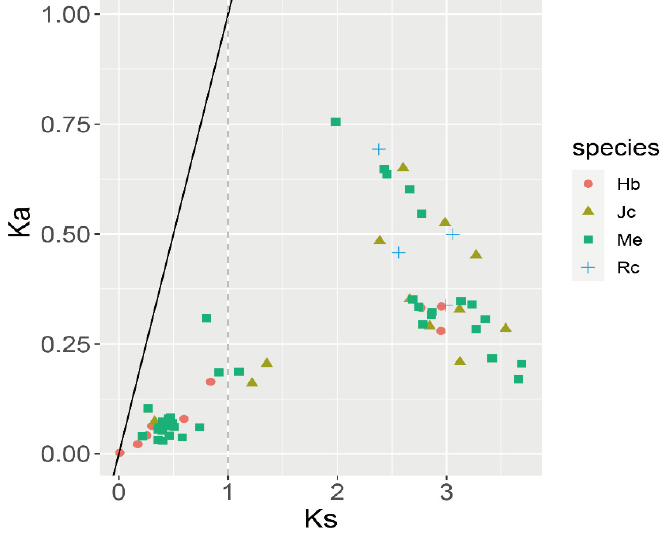
Figure 5. Selective pressure of Euphorbiaceae species LBD duplication genes. Red circles, yellow triangles, green rectangles, and blue crosses represent LBD duplication gene pairs of rubber tree, J. curcas , cassava, and castor, respectively.